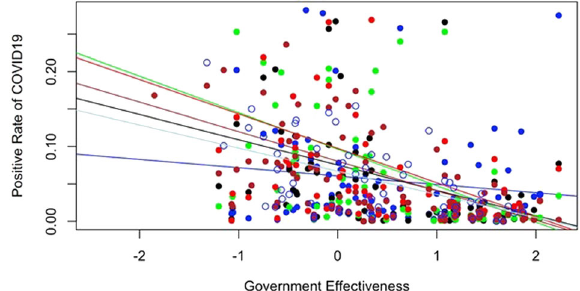
Fig. 5 The relationship between government effectiveness and the COVID- 19 growth